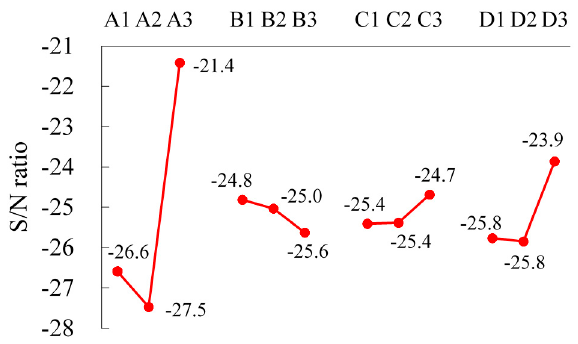
Figure 2. The factor response diagram for tensile strength.